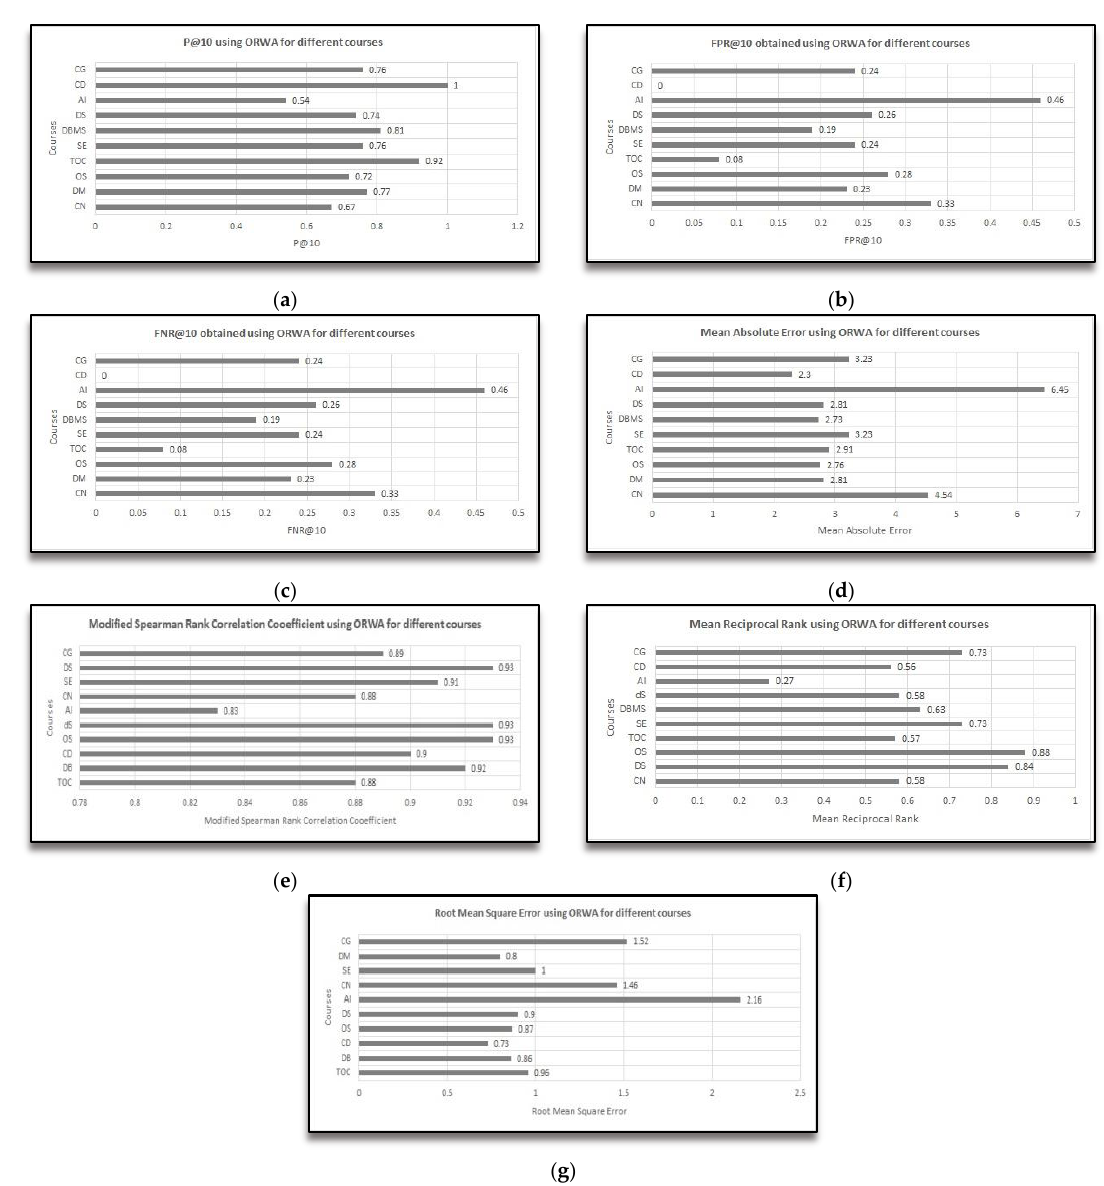
Figure 3. Results of different parameters using OWA (most preferred first) for books of all courses. ( a ) P@10 using OWA (most preferred first) for books of all courses. ( b ) FPR@10 using OWA (most